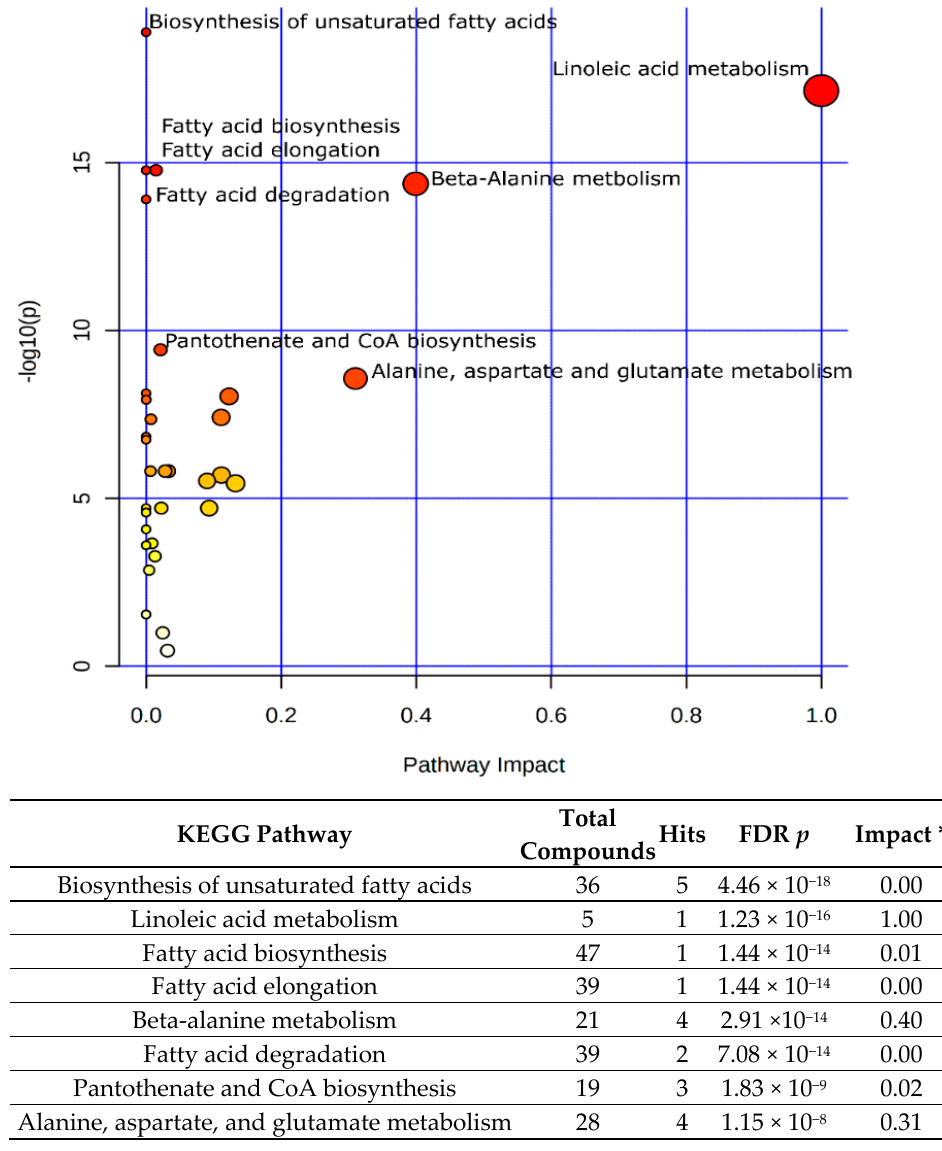
Figure 2. Overall pathway enrichment analysis of the 65 differential metabolites in the AIN, HFD, AIN + AOM, and HFD + AOM groups. Only the top 8 of 32 statistically significant pathways (Table S2) are listed here; the p -values are obtained by pathway enrichment analysis and adjusted by both Holm and FDR methods; the p -value and red-dot color intensity are inversely proportional. * The pathway impact score is obtained by pathway topology